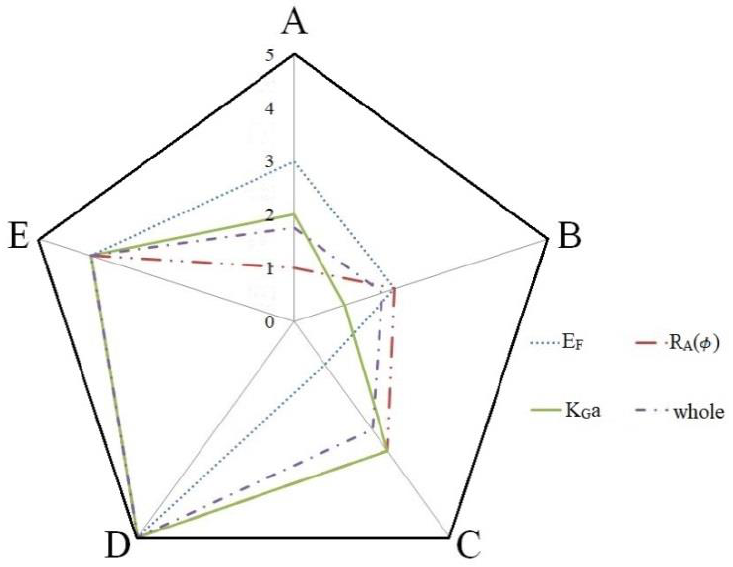
Figure 5. A radar chart showing the importance of the parameters.